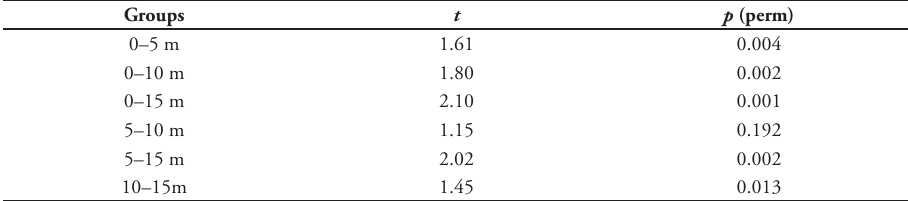
Table 1. Results of pair-wise tests of PERMANOVA for the factor depth, built on similarity (Bray Cur- tis) matrix of tintinnid